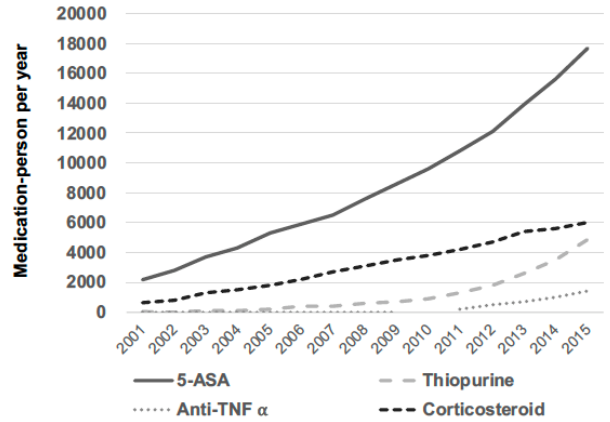
Figure 1. Annual prescribed IBD medication-person dosage.